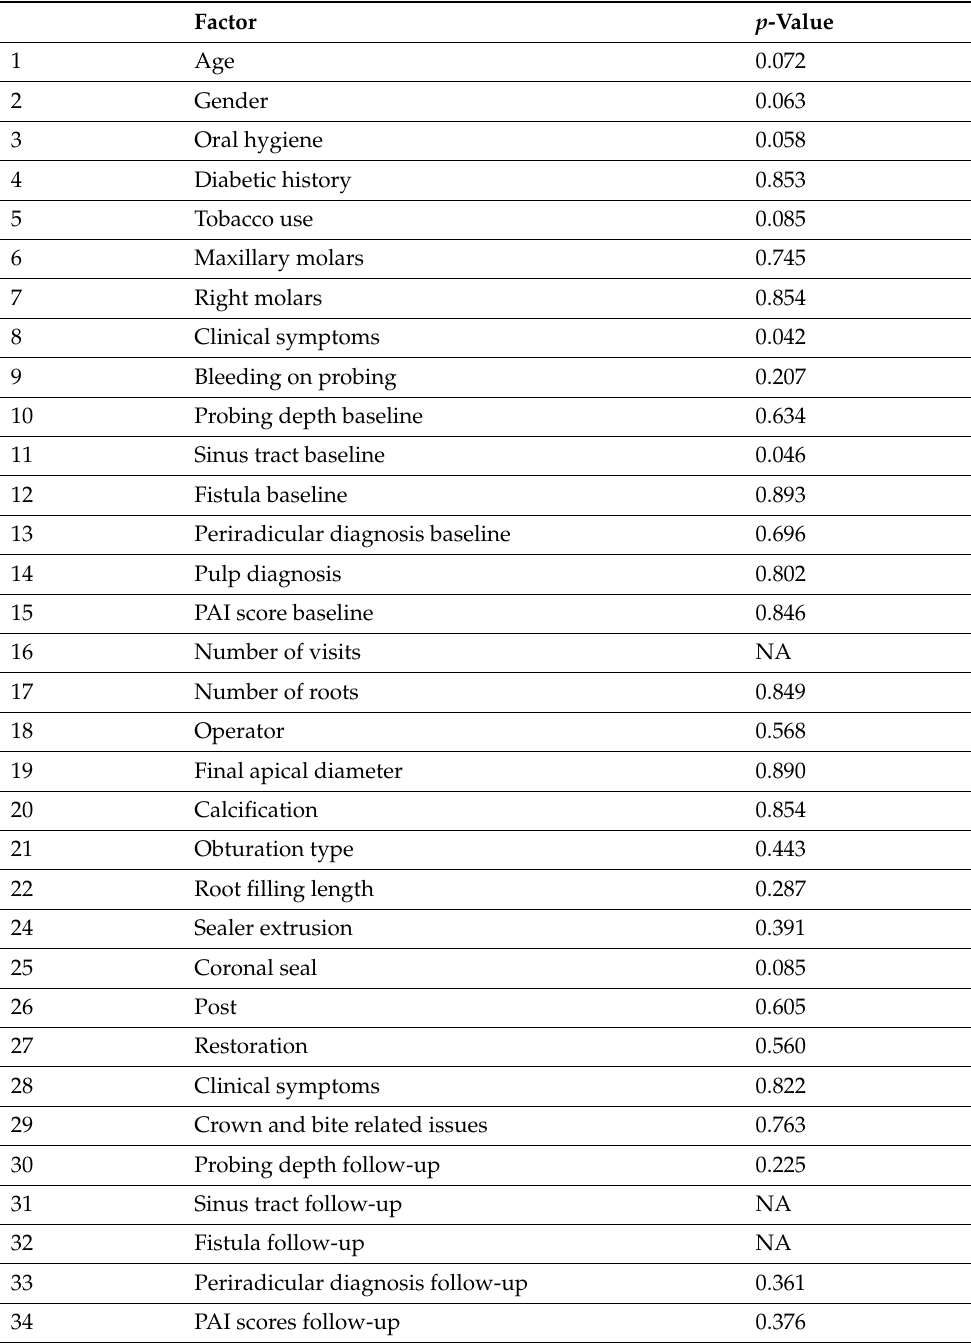
Table 3. The 34 variables. Description of all assessed outcome predictors and their